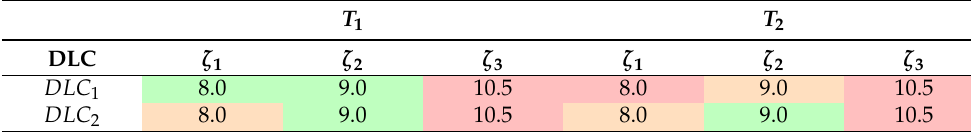
Table 7. Example pitch angle r [ 9 ] .